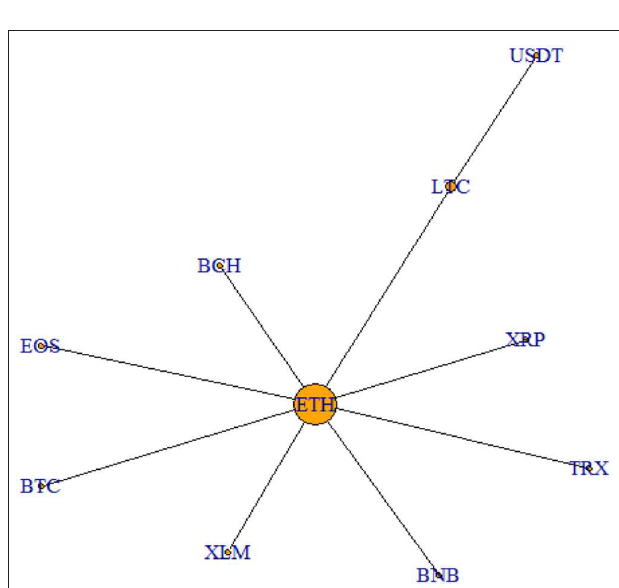
FIGURE 3 | MST September 2017–January 2018. This figure shows the MST representation relative to the period of the speculative